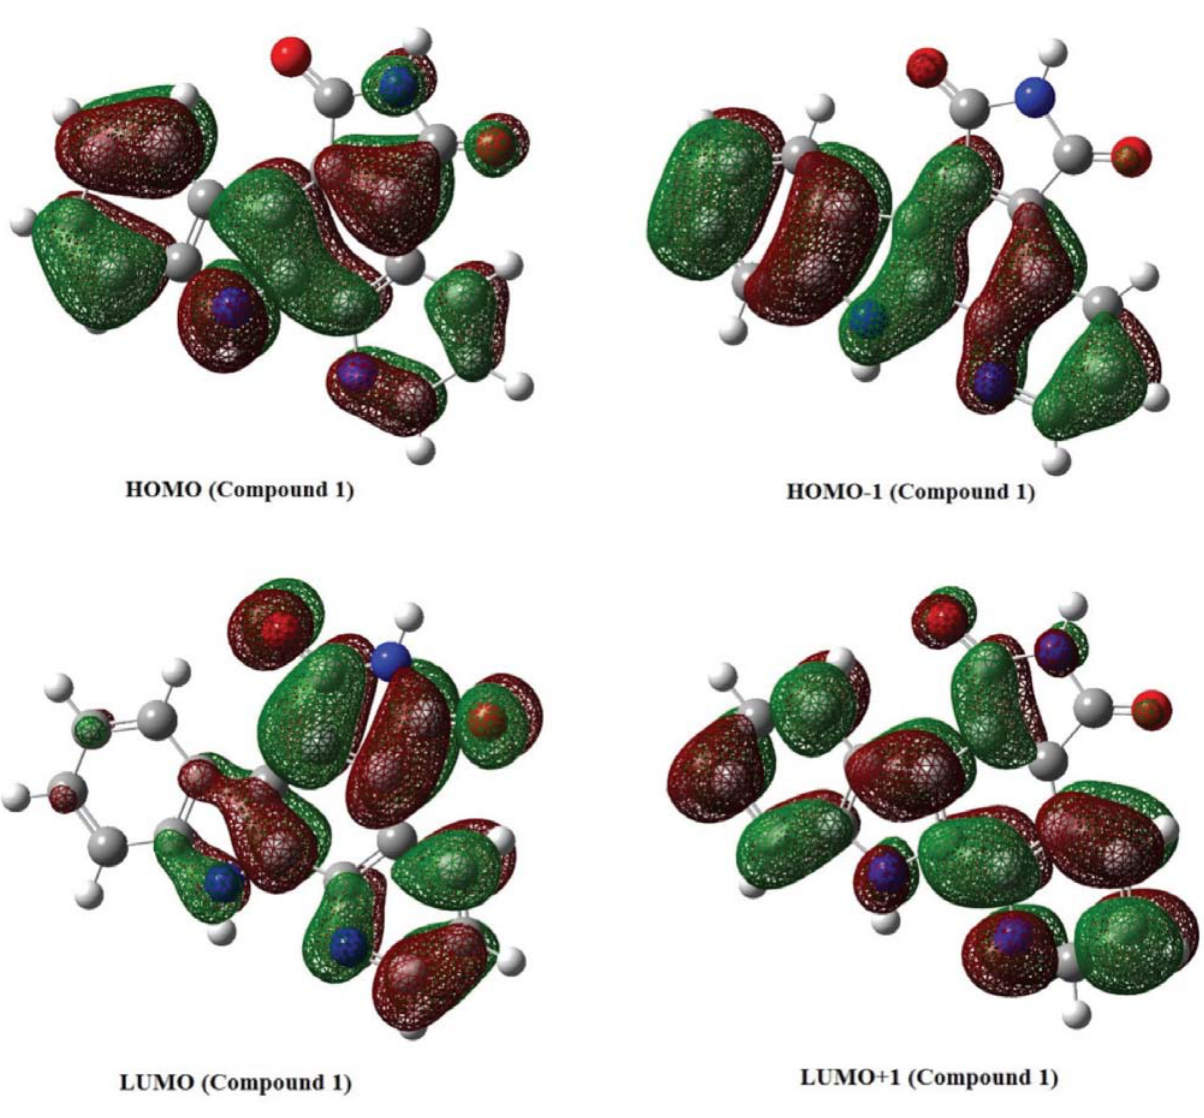
Figure 4. HOMO and LUMO molecular orbitals of the staurosporine derivative N,N-ligand ( 1 ) using the 6-311+G(d,p)